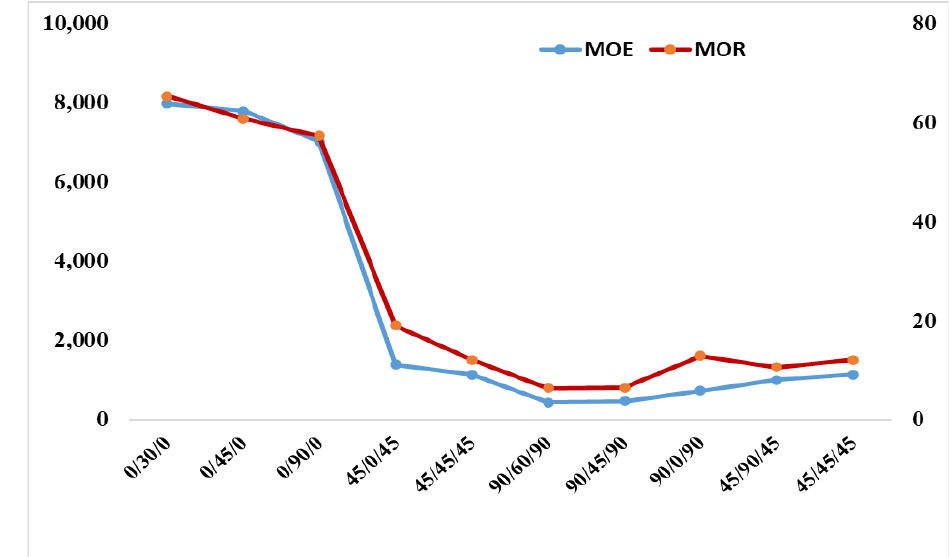
Figure 5. Relationship of MOE and MOR in various orientations.